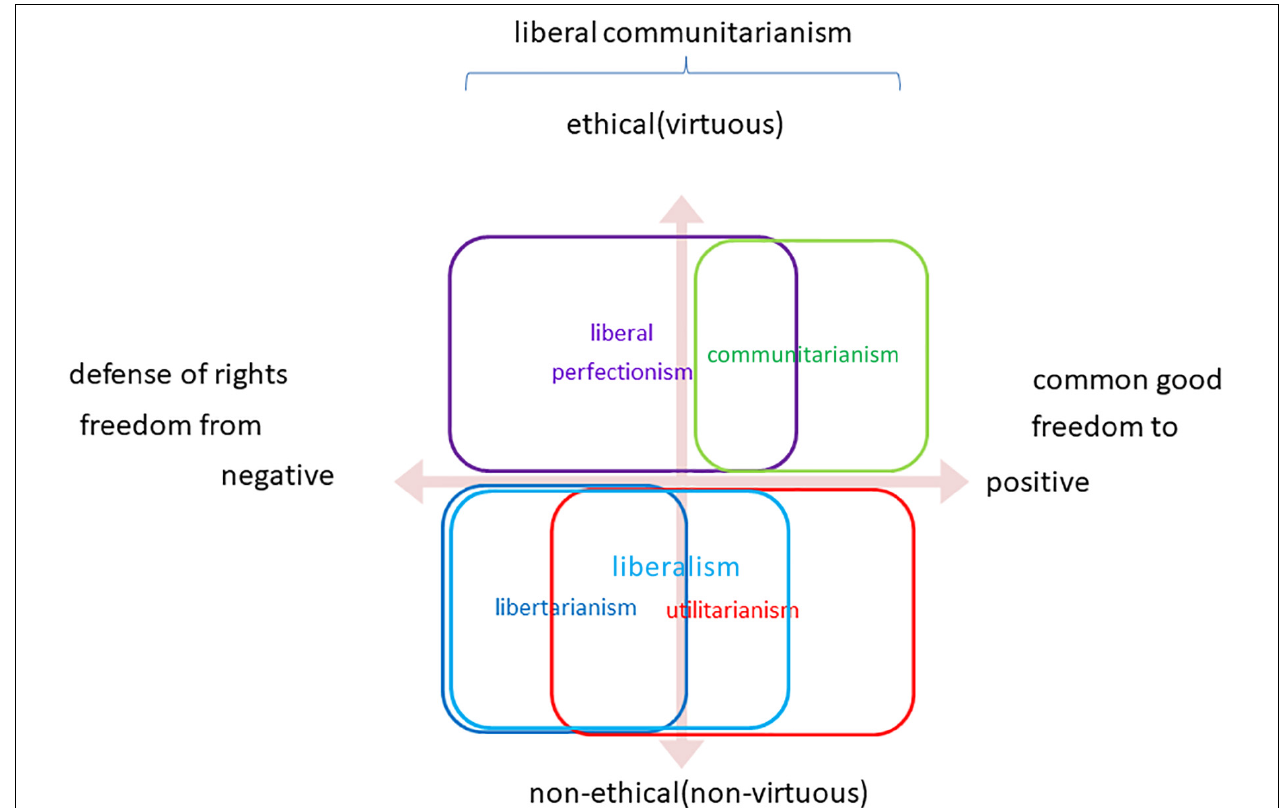
FIGURE 3 | Positive political